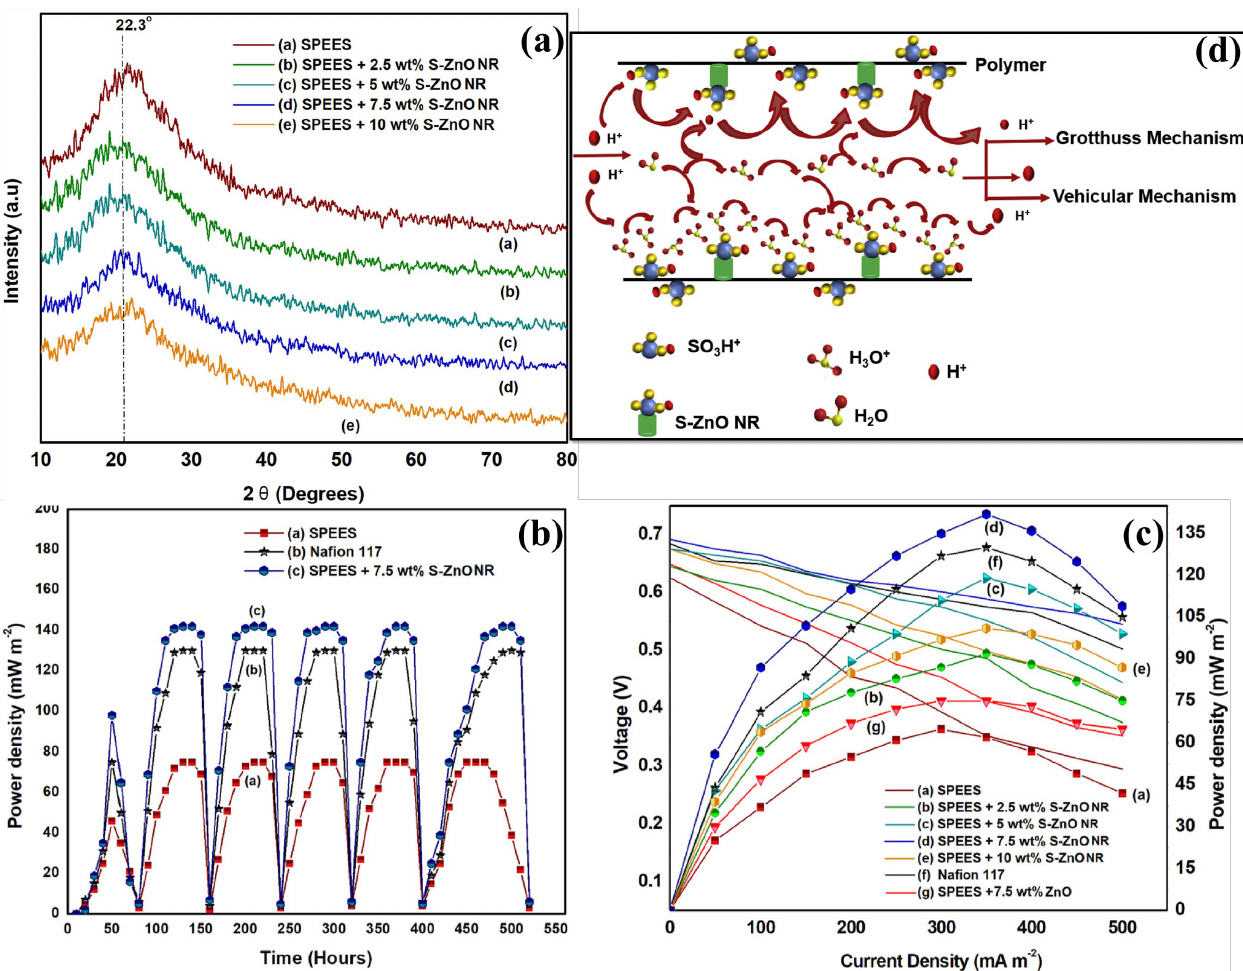
Figure 8. ( a ) XRD spectra of SPEES and different concentrations of sZnO NR (2.5, 5, 7.5, and 10%). MFC performances of ( b ) power density vs. time and ( c ) voltage vs. current density. ( d ) A graphic illustration of the ion transport mechanism in SPEES-sZnO NR composite membrane. Reproduced from [165], with permission from Elsevier, 2021.